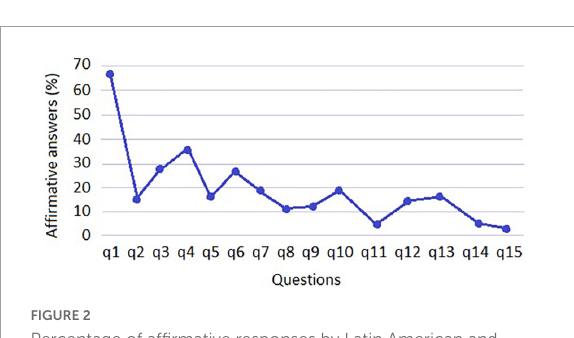
FIGURE2 Percentage of affirmative responses by Latin American and Caribbean food security scale (ELCSA) questions.